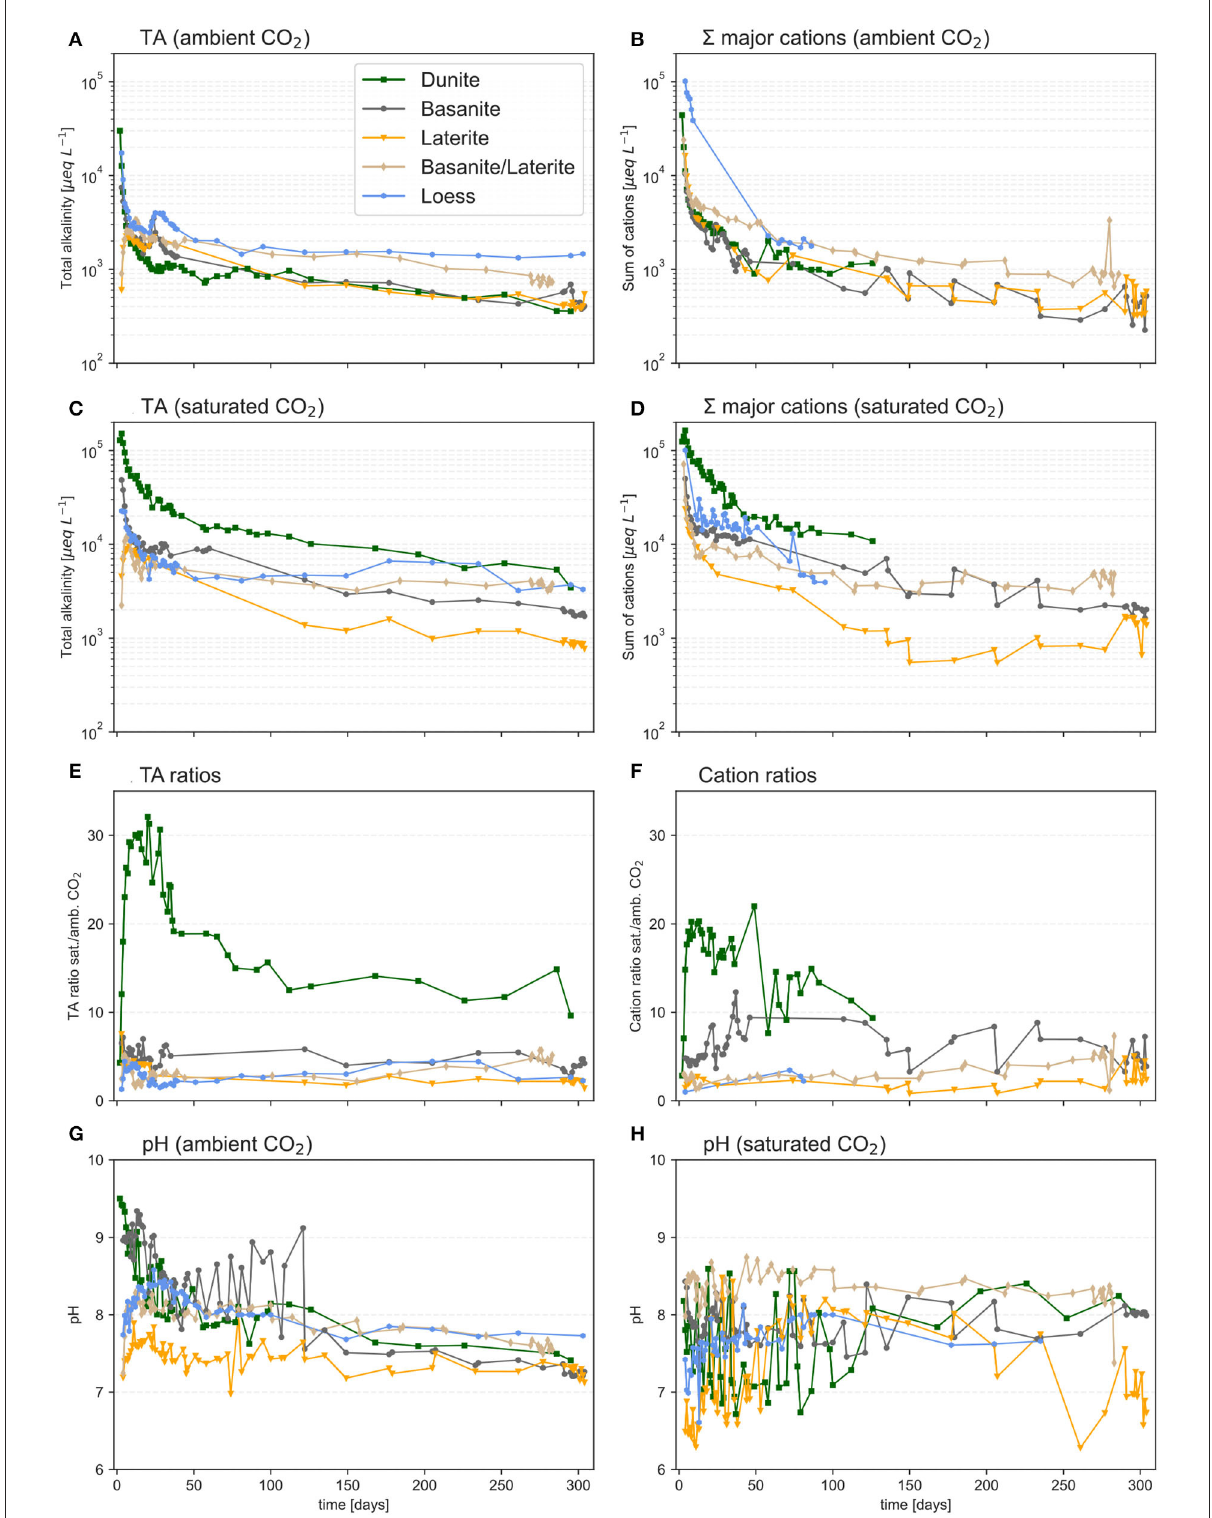
FIGURE3 Development of TA, the sum of cation equivalent concentrations, and pH in the columns treated under ambient (A,B,G) and saturated (C,D,H) CO 2 conditions. The ratios of TA and total cations (CO 2 saturated /CO 2 ambient ) are shown in (E,F) . pH is given in (G,H) , note the starting pH for water under ambient CO 2 was on average 5.34, while the starting pH under 100% CO 2 was on average